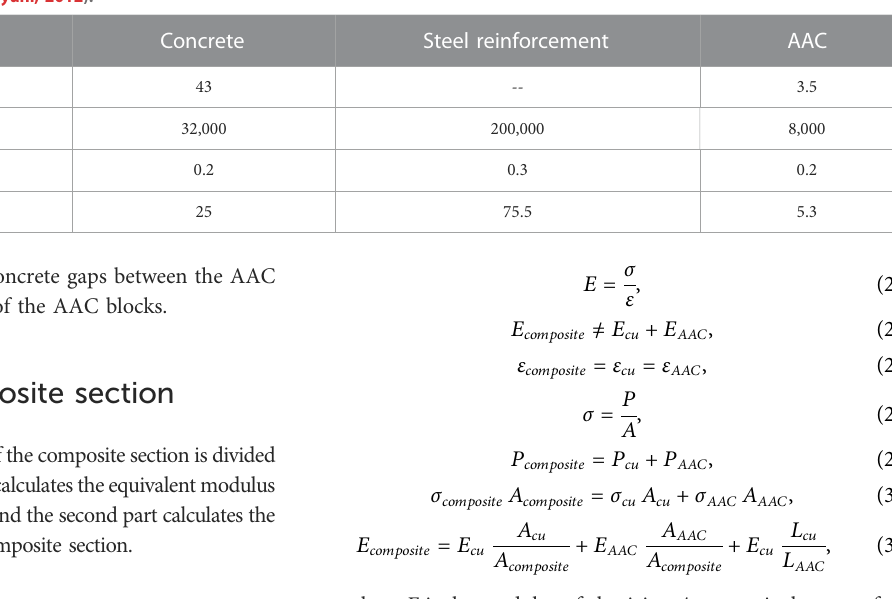
TABLE 2 Properties of the materials (Wahyuni,